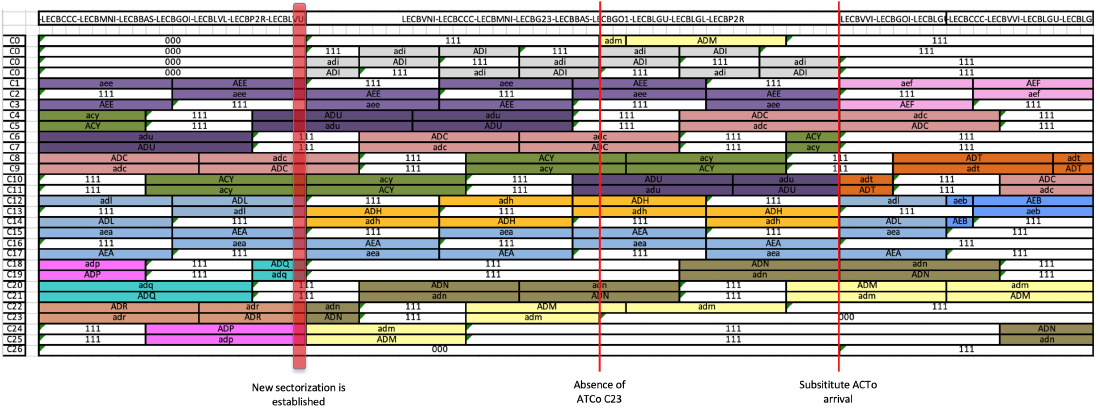
Figure 10. Solution derived from Phase 1 for Instance